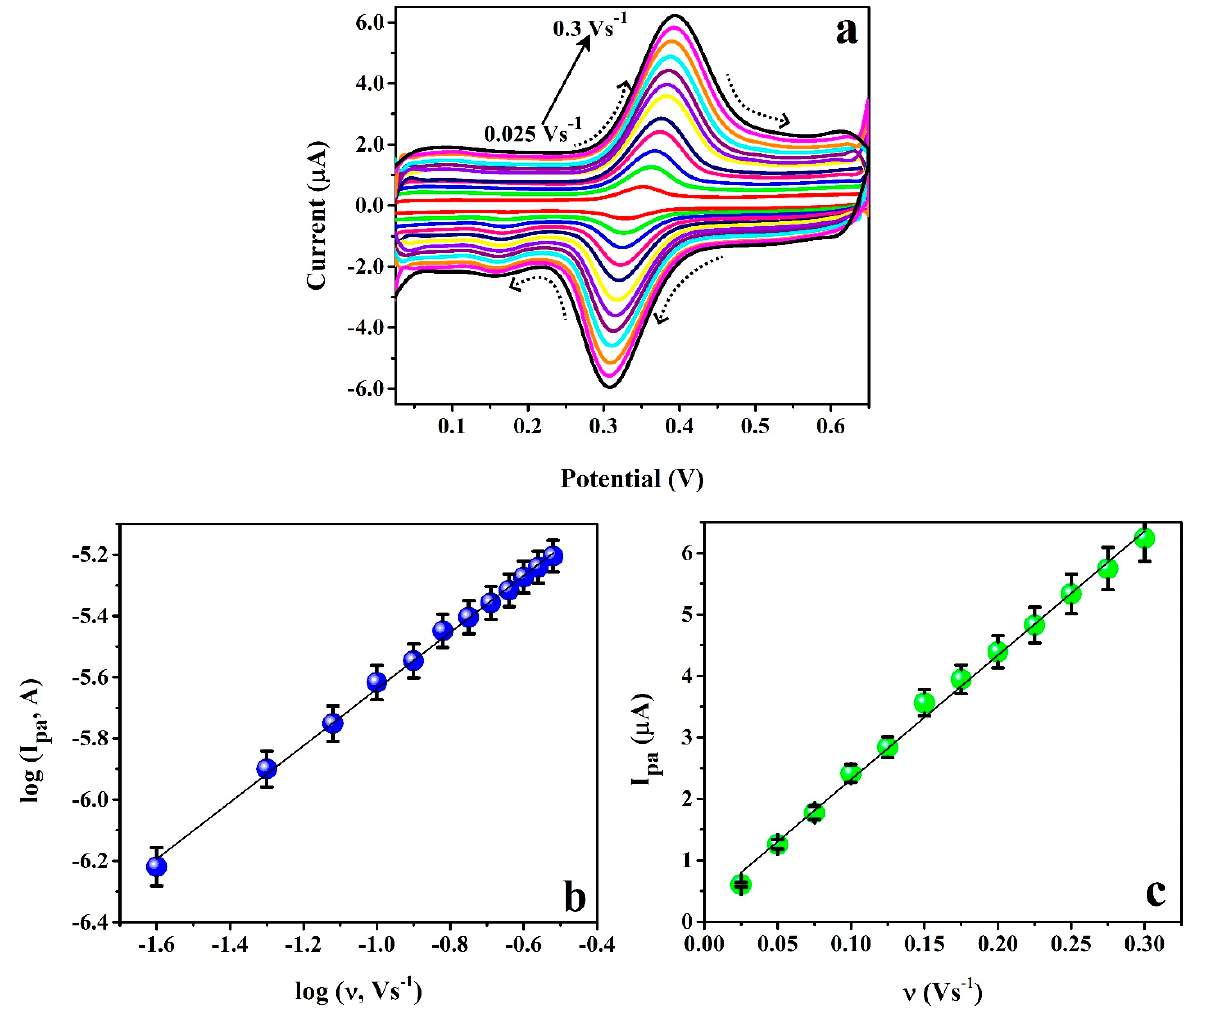
Figure 7. ( a ) Cyclic voltammograms for 0.01 mM ICN in 0.2 M PB of pH 6.5 at P(PAN)LCNTPE in the different scan rates ranging from 0.025 Vs − 1 to 0.3 Vs − 1 . ( b ) Plot of log I pa vs. log υ . ( c ) Plot of I pa vs. υ .